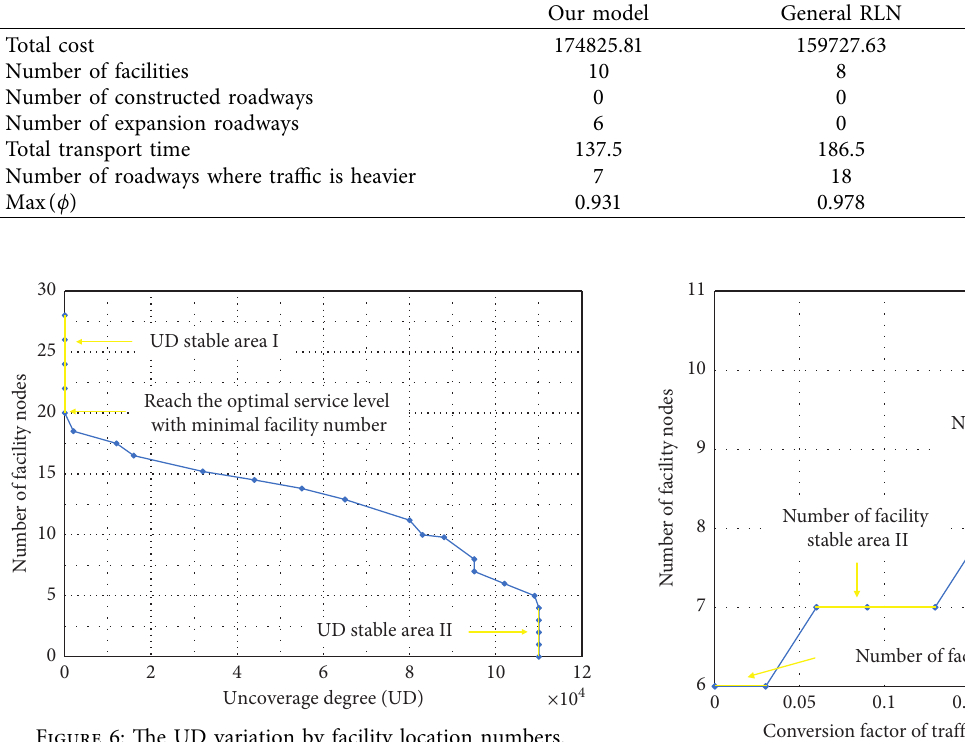
Table 3: Comparison of logistics network design solutions.